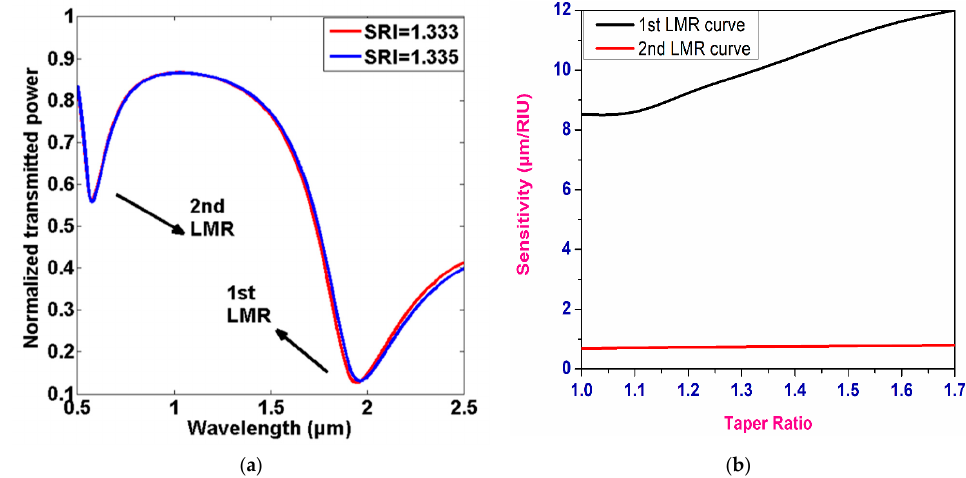
Figure 8. ( a ) Transmission curves for LMR-based FOS coated with ITO film at taper ratio 1.0, for two different SMRIs. ( b ) Sensitivity evaluation for first and second LMRs with taper ratio. Reproduced with permission from [74], copyright IOP Publishing. Table 2. Detailed summary of fiber optic LMR sensors for a wide range of coated materials, several geometries, and their utilization in various sensing schemes.